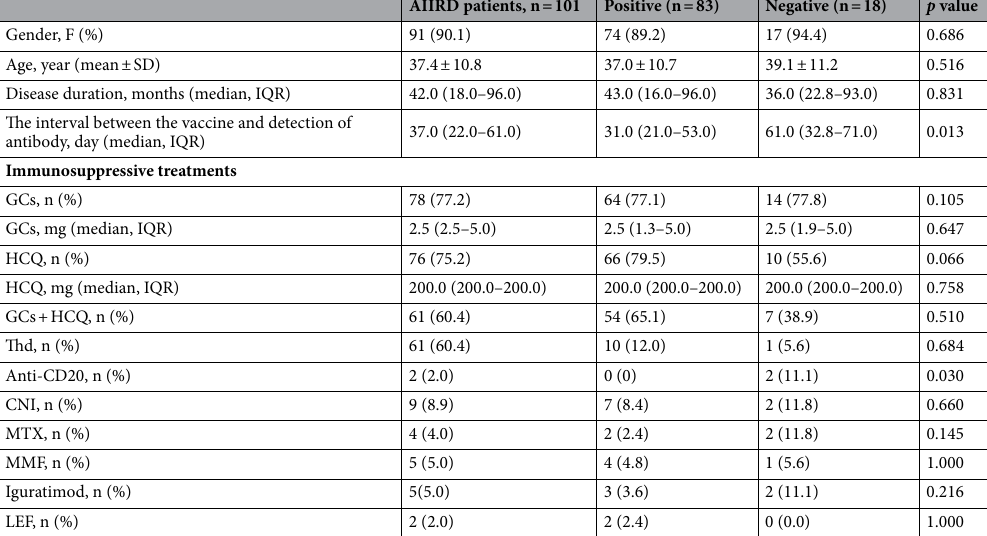
Table 2. Comparison between patients with positive and negative antibody in AIIRD. GCs glucocorticoids, HCQ hydroxychloroquine, Thd thalidomide, CNI calcineurin inhibitors, MMF mycophenolate mofetil, MTX methotrexate, LEF leflunomide.